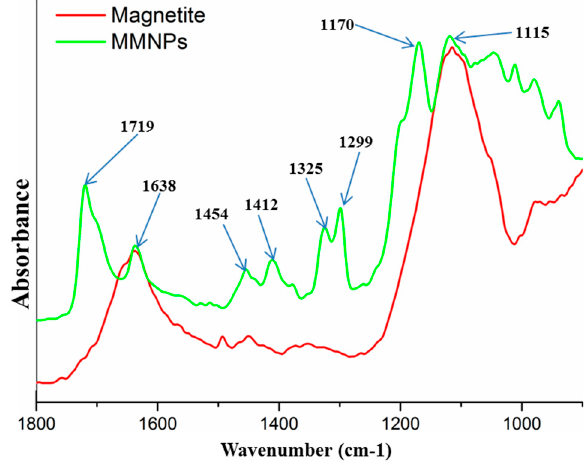
Figure 4. FTIR spectra for magnetite and double bond functionalized magnetite nanoparticles .